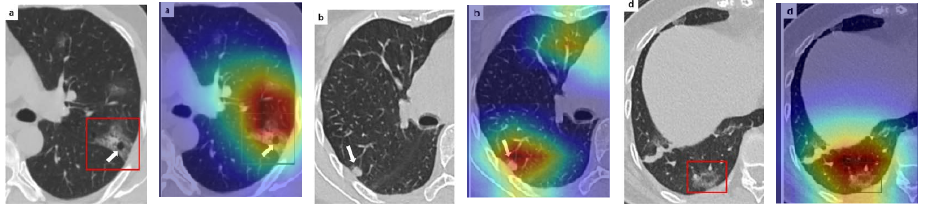
Figure 17. Example of annotated CT scans with different manifestations of COVID-19 taken from [61], and their corresponding localization maps. Our models were able to identify them as COVID-19 cases and accurately localize their COVID-19-associated